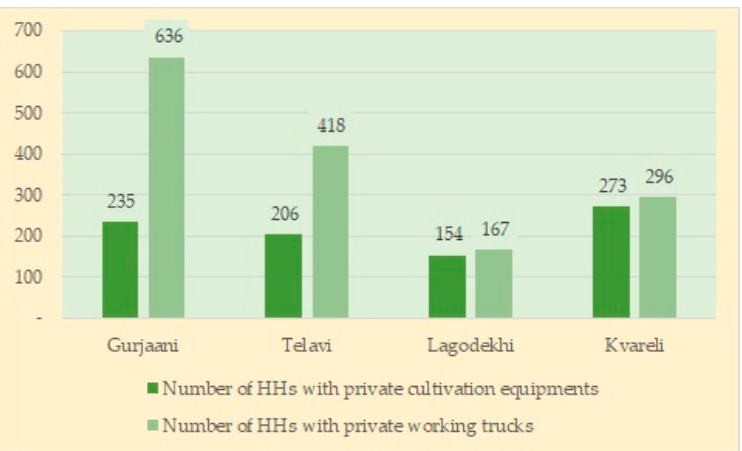
Figure 9. Number of HHs with land cultivation and trucks in property.